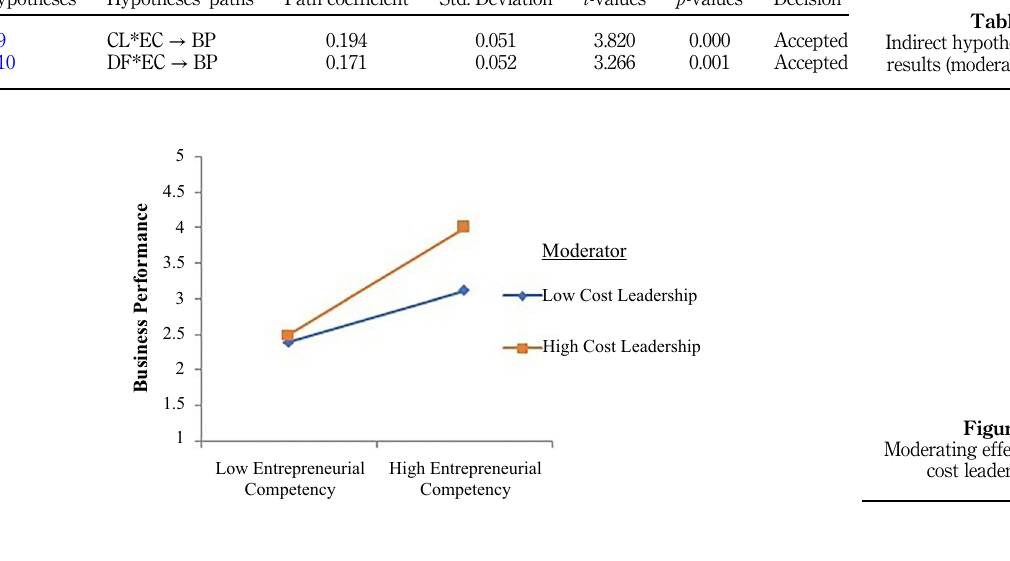
Table 8. Indirect hypotheses ’